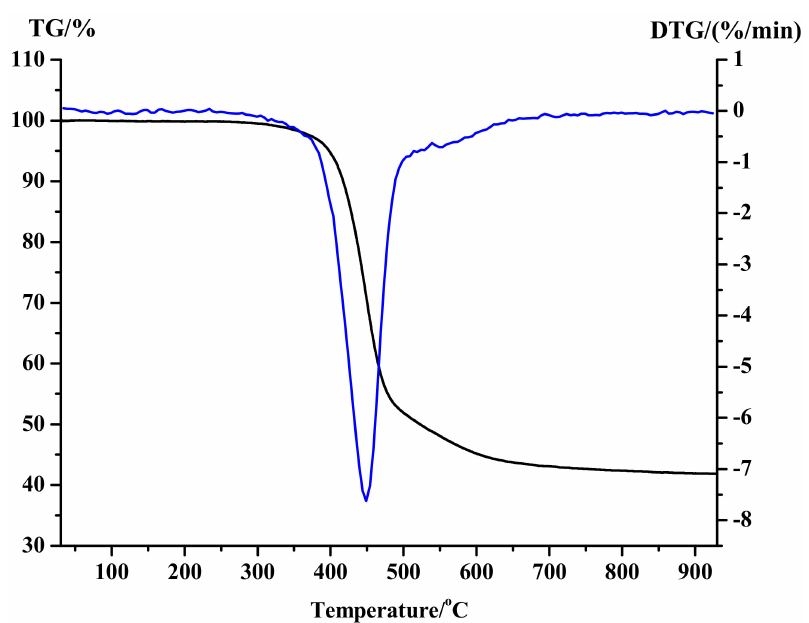
Figure 1. TGA (black) and DTG (blue) of BPEA.